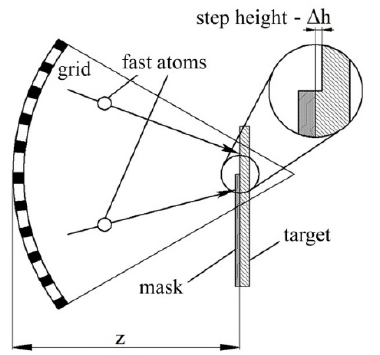
itssurfaces at a the grid voltage of U = 5 kV, the argon pressure of 1.0 Pa and the anode current of I a = 1